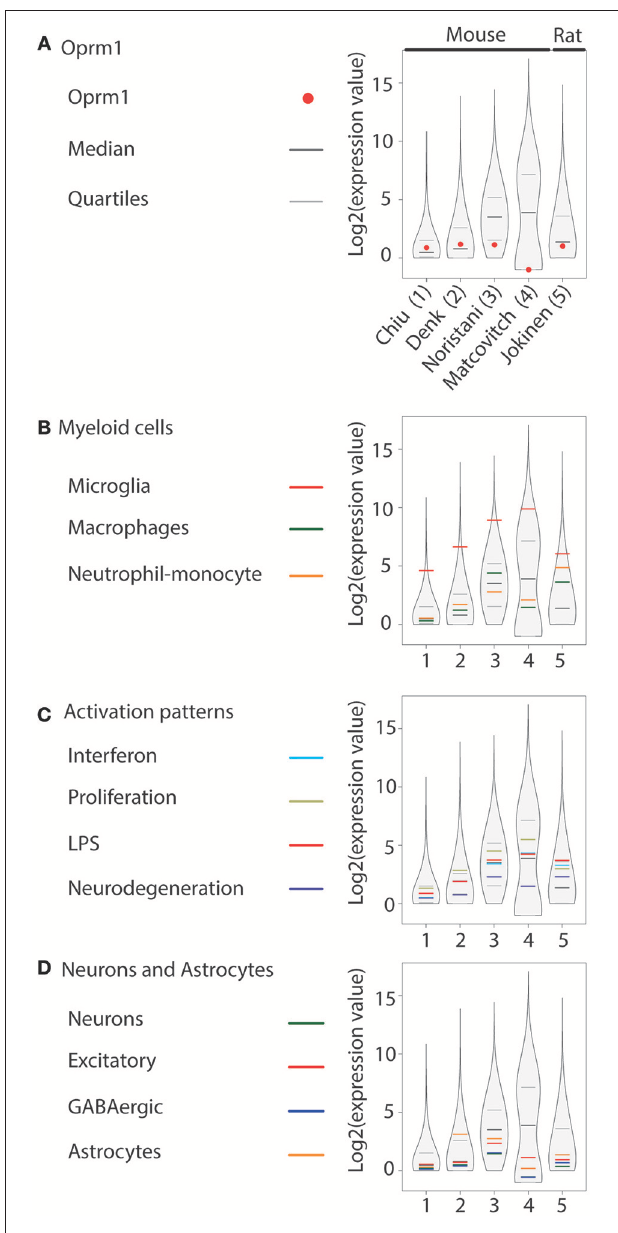
FIGURE 3 | Oprm1 and gene clusters expression in rodent spinal cord microglia datasets. Expression levels of the genes identified in each dataset are represented in violin plots demonstrating the median, as well as the 25th and 75th quartiles. Datasets are represented by name of the first author in (A) which are denoted numerically in (B–D) . Gene expression in the spinal cord was assayed with RNA-seq exclusively. (A) Oprm1 expression values ranged from above the median to undetected level (#4). (B) In the Myeloid gene cluster, the Microglia- related genes were the mostly highly expressed in all datasets analyzed, with expression values distributed about the 75th quantile. (C) Proliferation-related genes were the most highly expressed within the Activation pattern clusters, except in dataset#5, which had higher expression values for the LPS module in microglia purified from rat. Overall, the expression values of Activation patterns gene clusters were low compared to the Microglia-related genes. (D) Neuron-, GABAergic- and Astrocyte-related genes had expression values that were low compared to the Microglia-related genes except for dataset #2 that show high Astrocyte-related module expression (B)